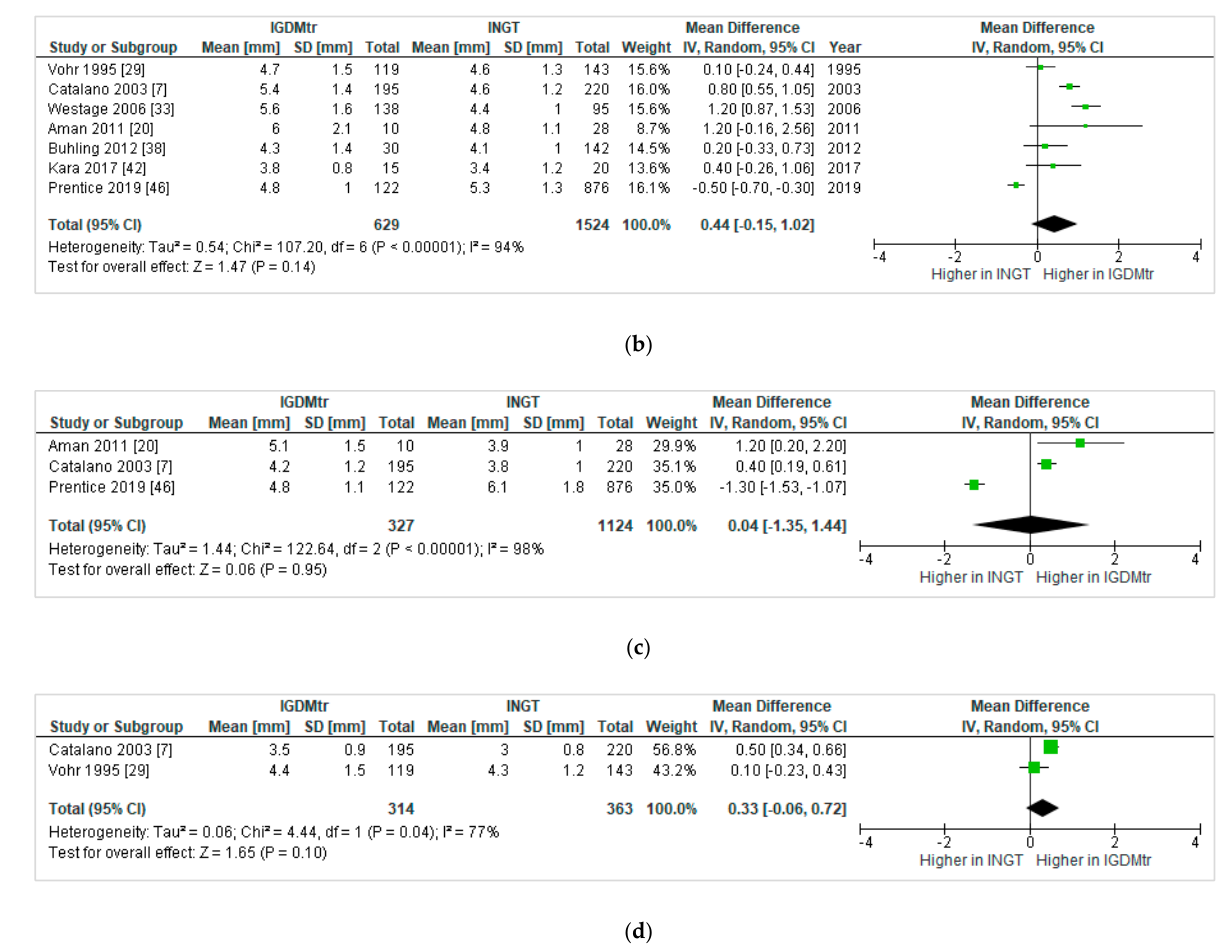
Figure 4. Forest plots comparing skinfold thickness (mm) at triceps ( a ), subscapular ( b ), flank ( c ) and abdomen ( d ) in infants exposed to treated gestational diabetes mellitus (IGDMtr) and infants exposed to normal glucose tolerance (INGT). Heterogeneity between the Studies that Compared GDMtr vs. NGT